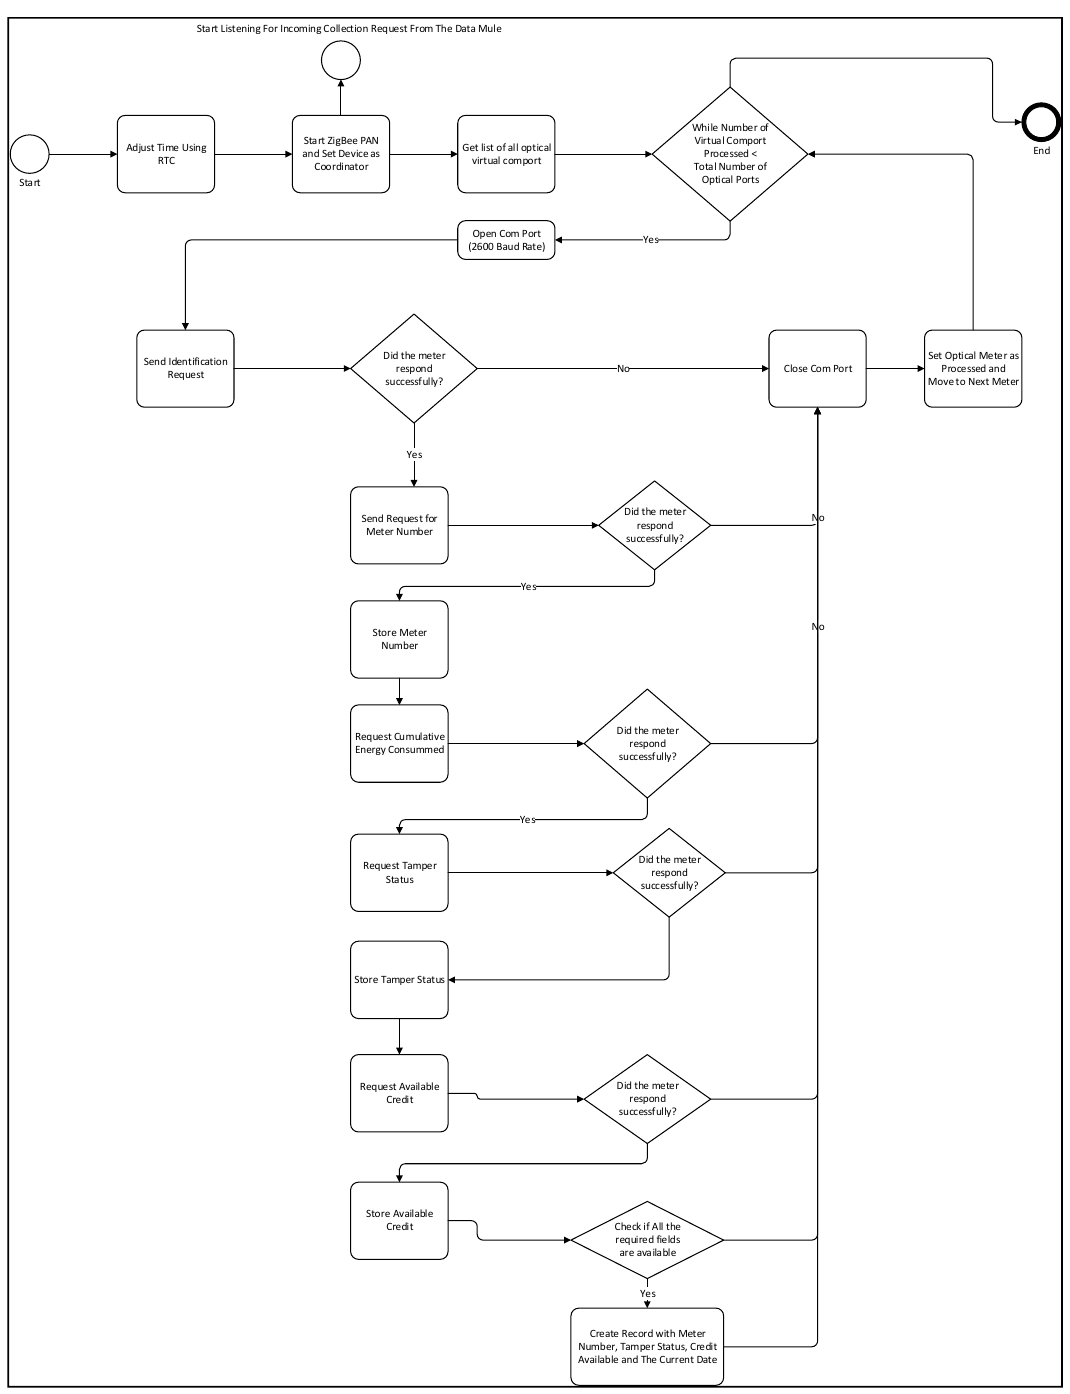
Figure 8. Data Concentrator Meter Reading Flow Diagram (Low number smart meters).